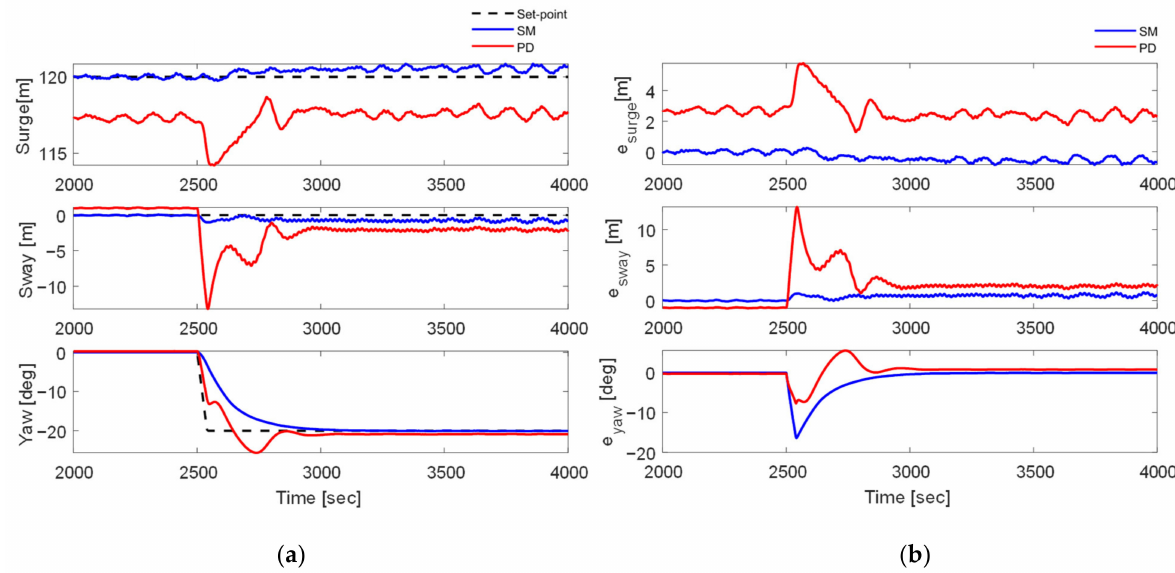
Figure 11. Simulation results of the dynamic motions of FPSO vessel and relative errors with a comparison of the SM and PD controllers according to case 1 according to: ( a ) dynamic motions and ( b ) relative